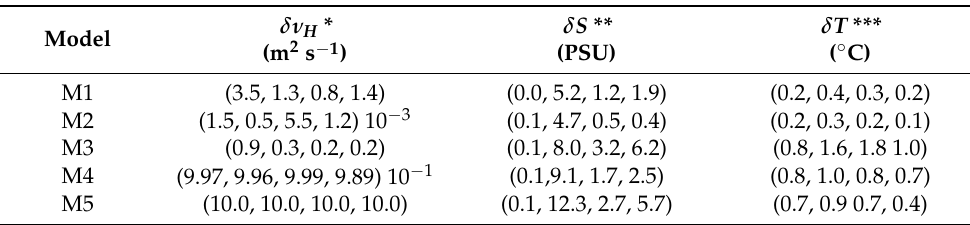
Table 4. Bias for the four stations (in parentheses) and for the turbulence schemes (M1–M5). δ was calculated relative to